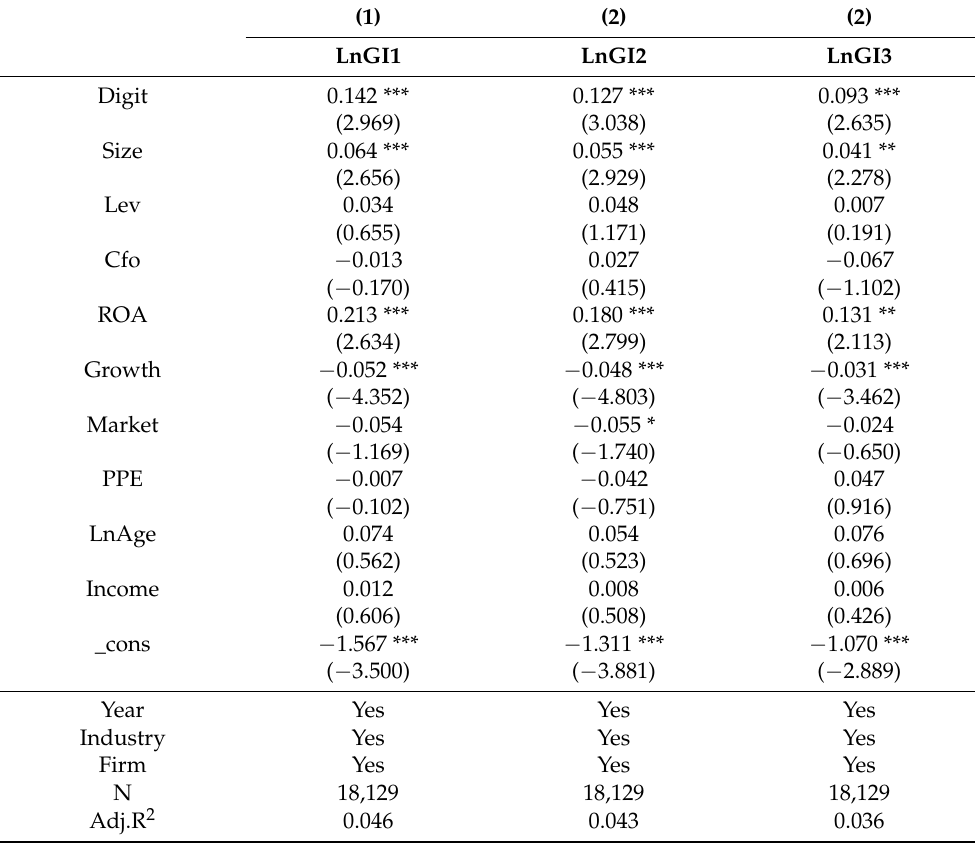
Table 7. The results after deleting the current year of the list sample .